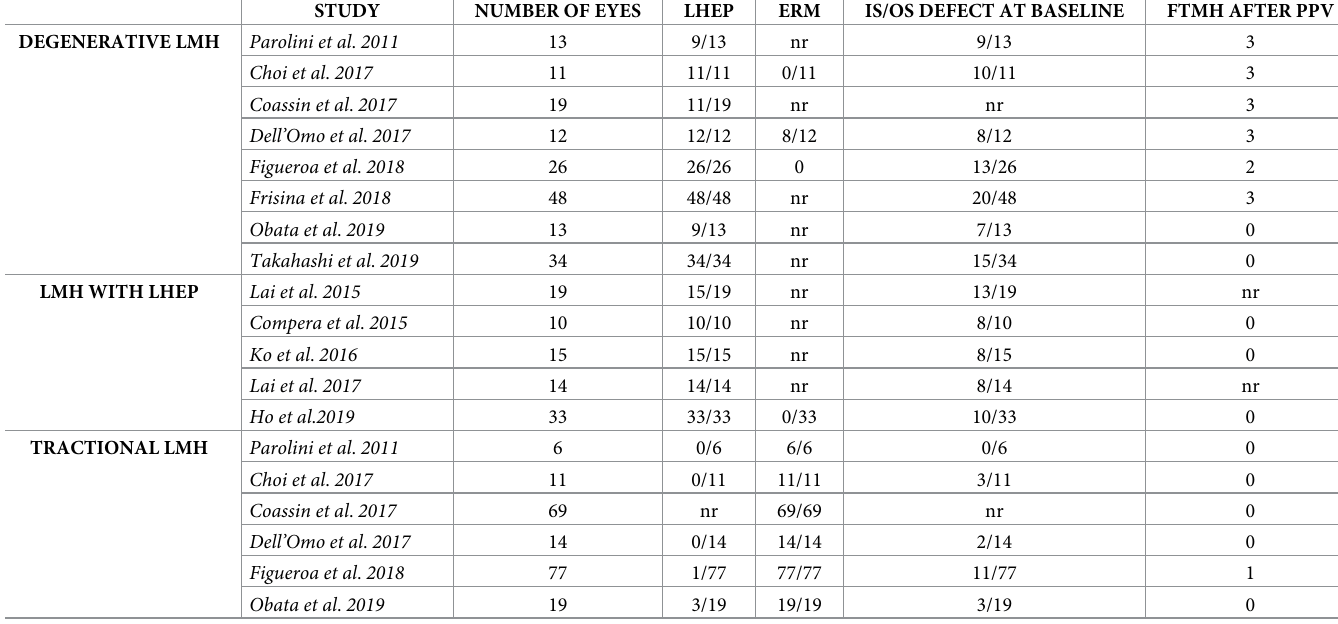
Table 1. Characteristics and grouping of included studies.